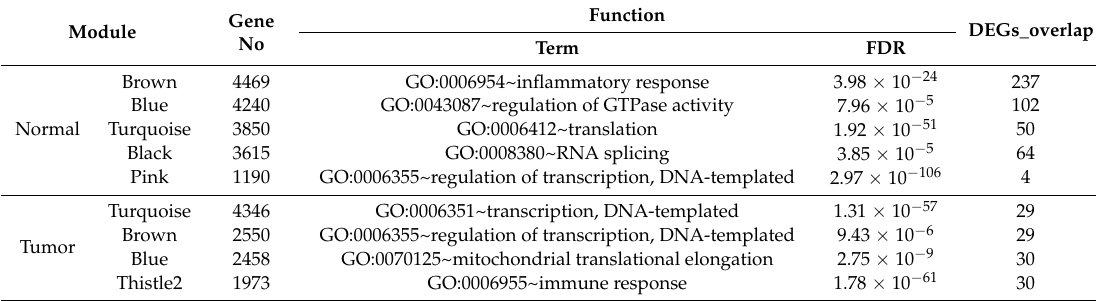
Table 2. The summary of gene number and the main function of the top 5 co-expression models in normal and cancer